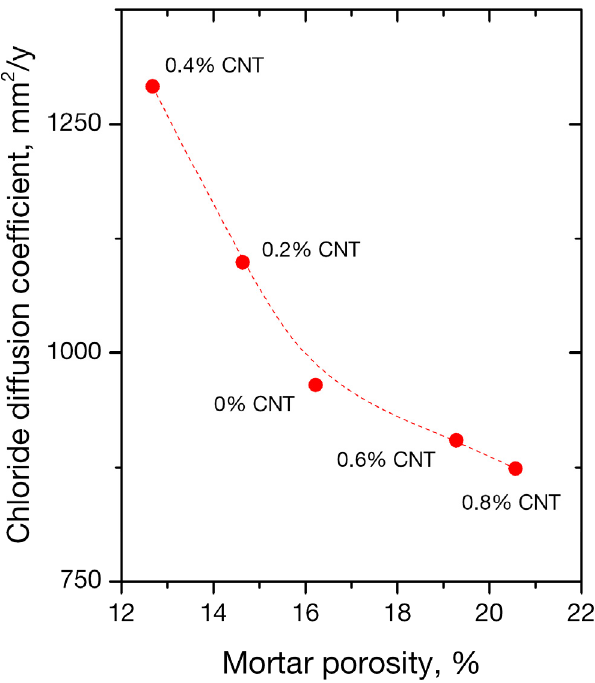
Figure 10. Chloride diffusion coefficient a function of mortar porosity.